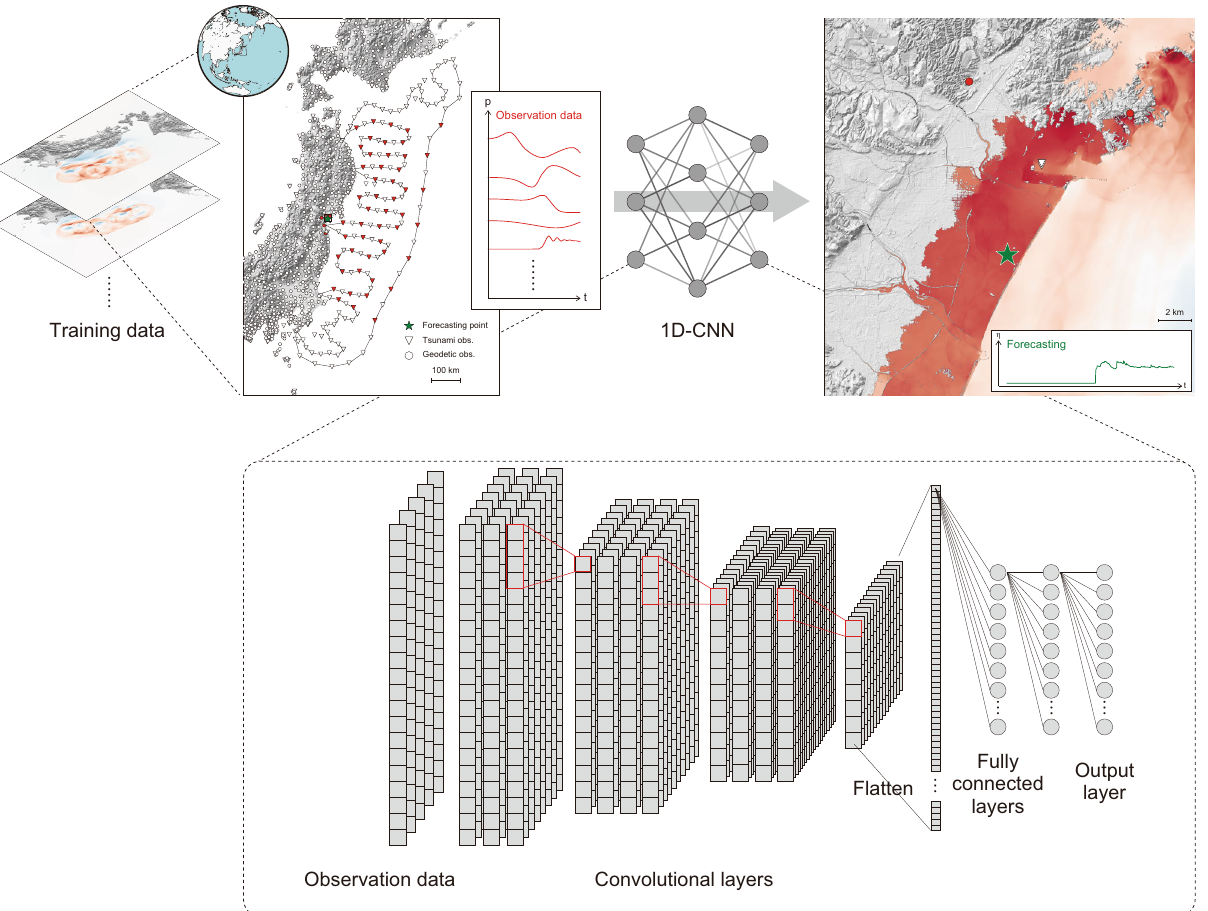
Fig. 1 Schematic view of tsunami forecasting by the convolutional neural network (CNN). The CNN learns the relation between observation data and the resulting tsunami waveform from thousands of numerical simulation results. The tsunami and geodetic observation points are uniformly selected to cover the forecasting areas and are illustrated as red points in the map. After the training process is completed, the trained CNN can predict a time series of inundation tsunami waveform at the onshore forecasting site, which is represented with a green star, solely from observation data for unknown tsunami